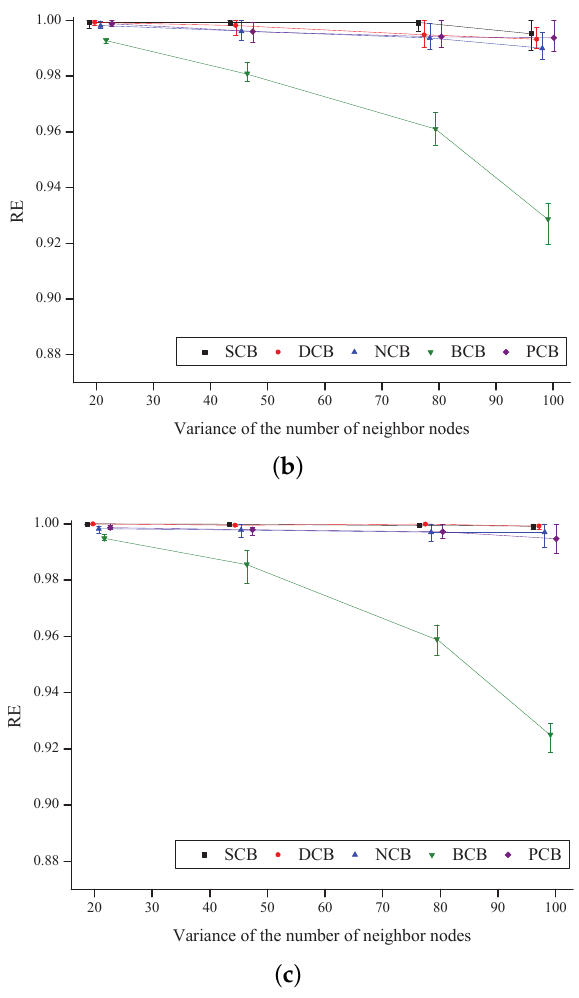
Figure 13. Reachability ( RE ) as a function of the variance of the number of neighbor nodes. ( a ) C max = 3; ( b ) C max = 4; ( c ) C max = 5.